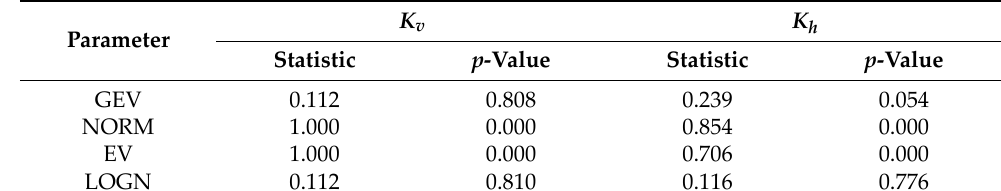
Table 7. Statistic and p ‑value in the Kolmogorov‑Smirnov test of the NRB specimen. Table 8. Statistic and P ‐ value in the Kolmogorov ‐ Smirnov test of the LRB specimen